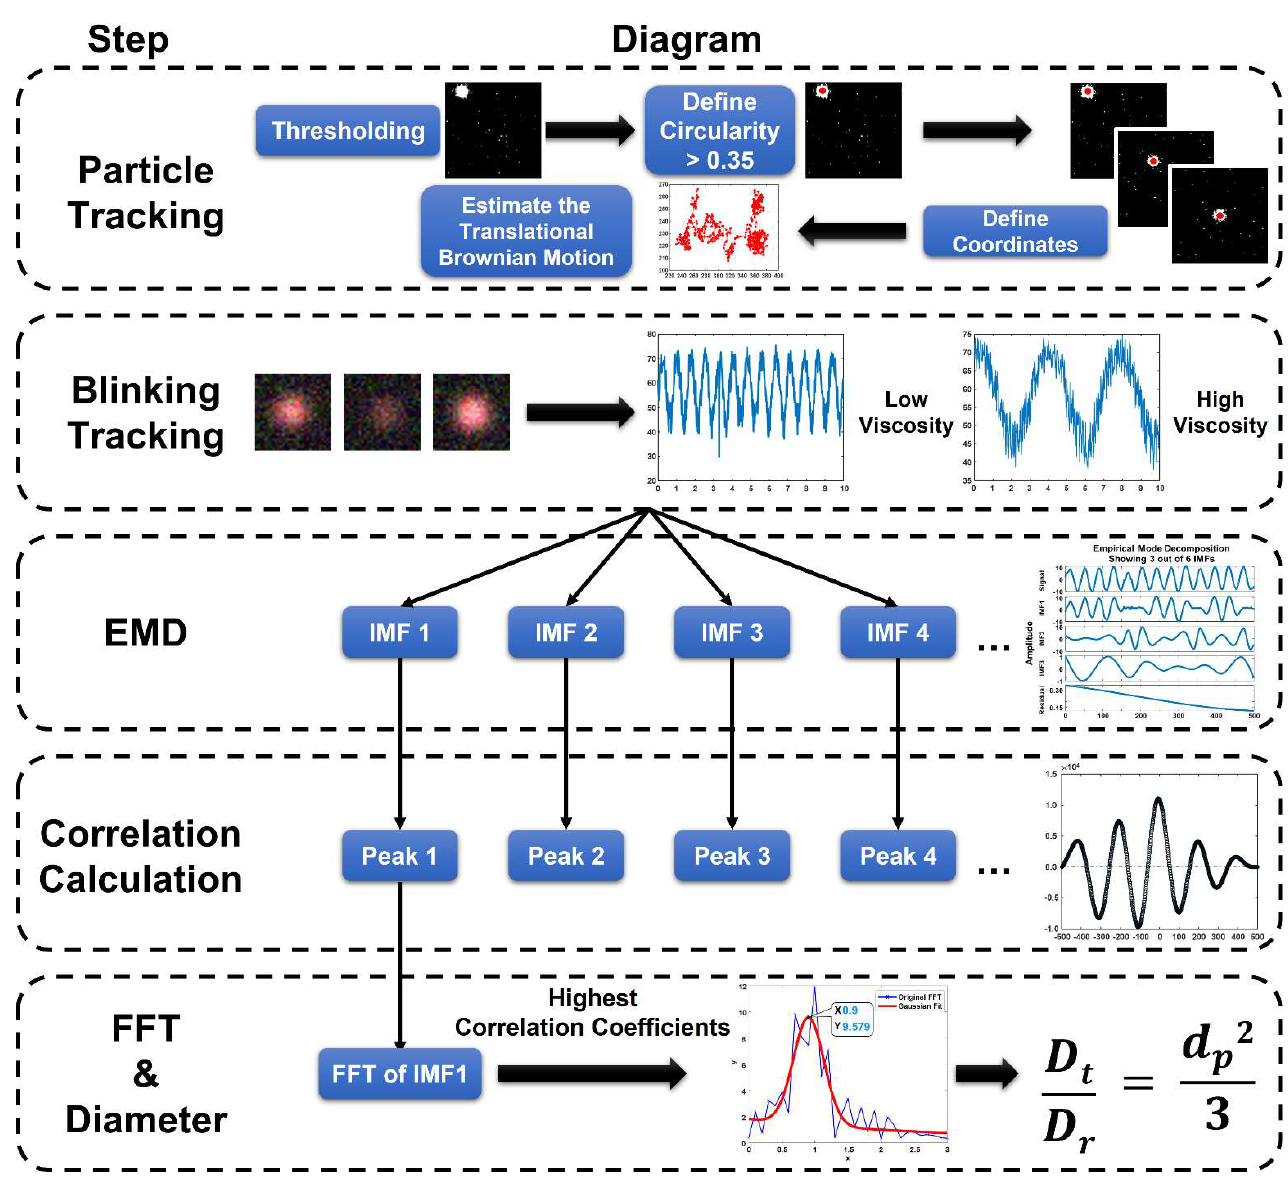
Figure 2. The schematic of the self−viscosity and temperature−compensated technique step. The particle tracking was used to evaluate the translational and the rotational diffusivities. The particle images were binarized by thresholding to define the circularity of each particle. The coordinates of each particle were defined after removing the close particles. The blinking signal of the particle was captured according to particle coordinates. To eliminate the noise of the blinking signal, EMD was applied to decompose the blinking signal into several IMFs. The particle diameter was derived by dividing the translational diffusivity by the rotational diffusivity.